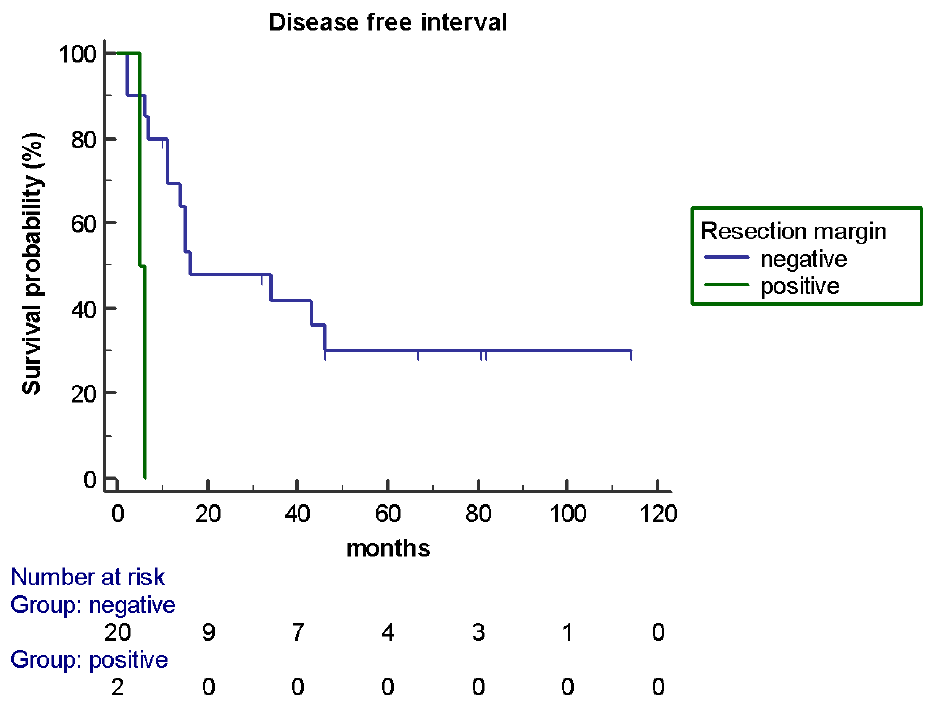
Figure 4. DFI according to resection margin of liver metastases (R0 versus R1: 16 versus 5 months; HR 0.17, p =